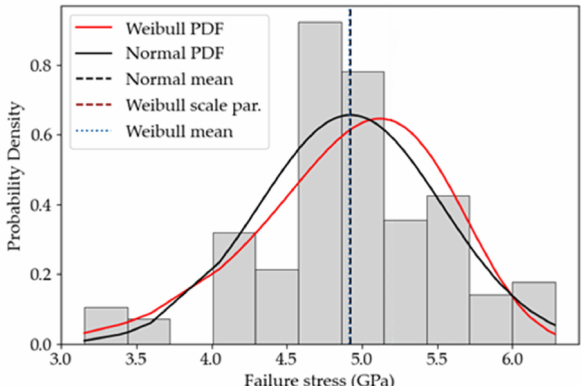
Figure 8. Data reduction approach A. Histogram of the failure stress of all the tested devices, and fitting with two-parameter Weibull and normal probability distributions. The mean values relevant to the two distributions are represented by the vertical dotted lines.